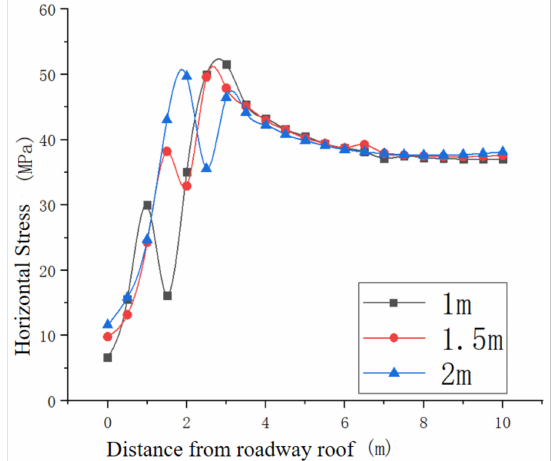
Figure 9. Horizontal stress distribution of surrounding rock in roadways of hard rock layers of different